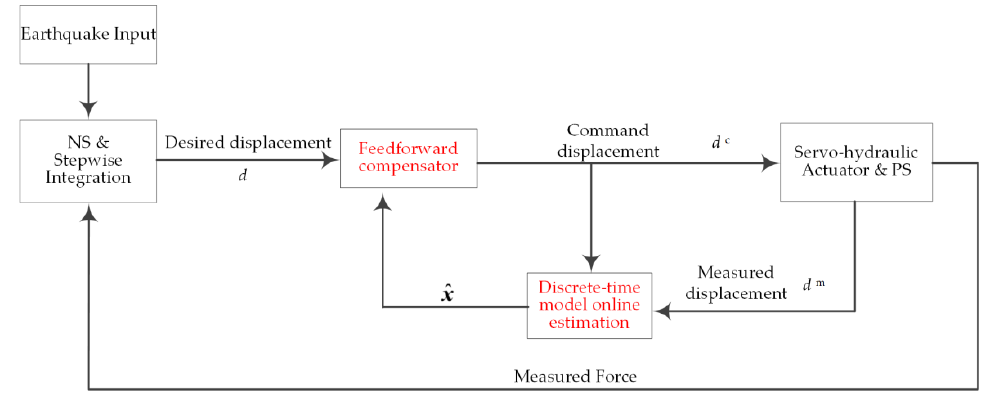
Figure 3. Block diagram of RTHS using the KF-ADC strategy.